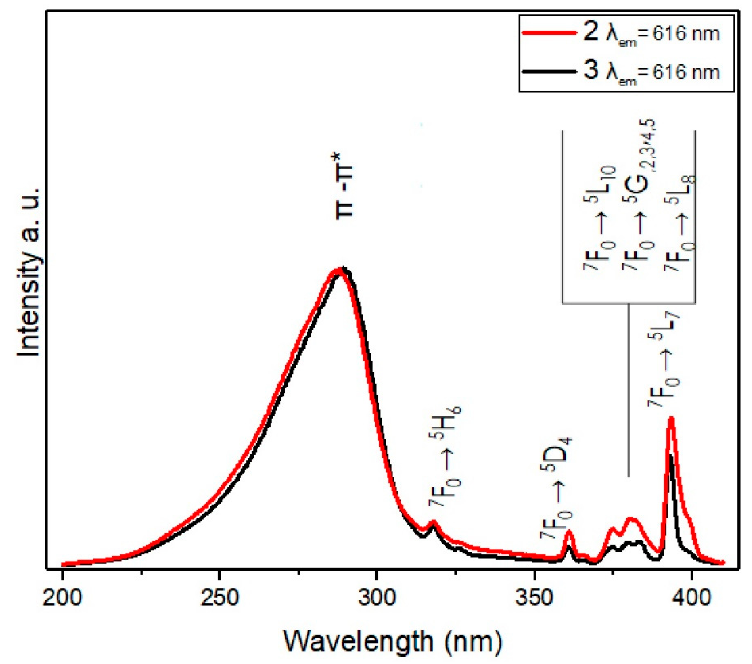
Figure 9. Excitation spectrum with λ em = 616 nm, for 2 : [Eu(OOCC 6 H 5 ) 3 ·(H 2 O) 3 ] and 3 : [Eu(OOCC 6 H 5 ) 3 ·(HOOCC 6 H 5 ) 2 ].